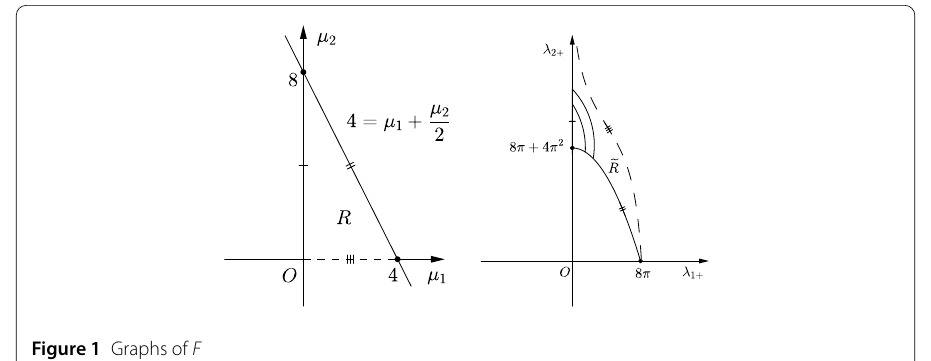
Figure 1 Graphs of